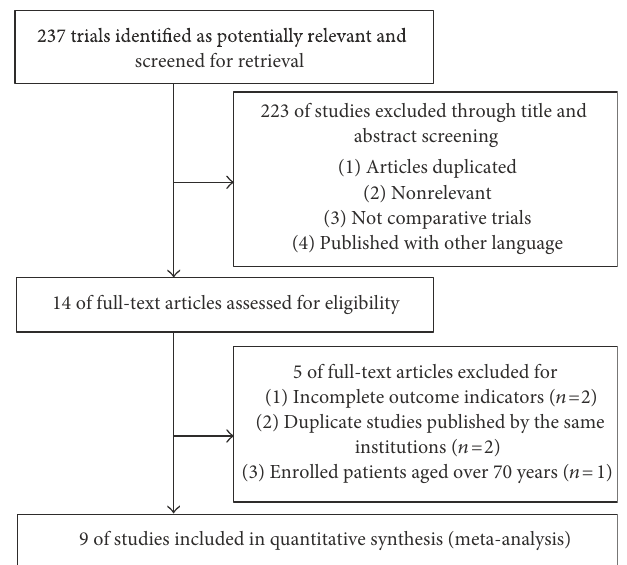
Figure 1: Flow chart of study search. A total of 9 studies ultimately included for